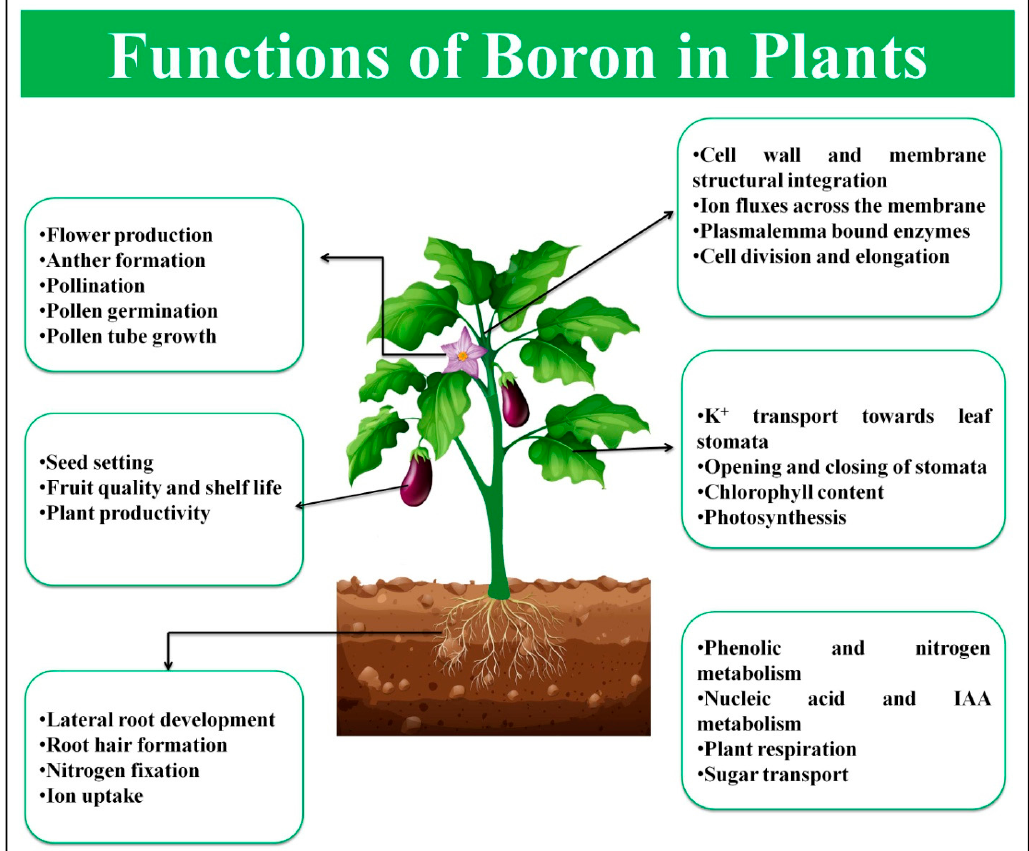
Figure 1. Functions of B in different parts of plant. IAA: Indoleacetic acid.